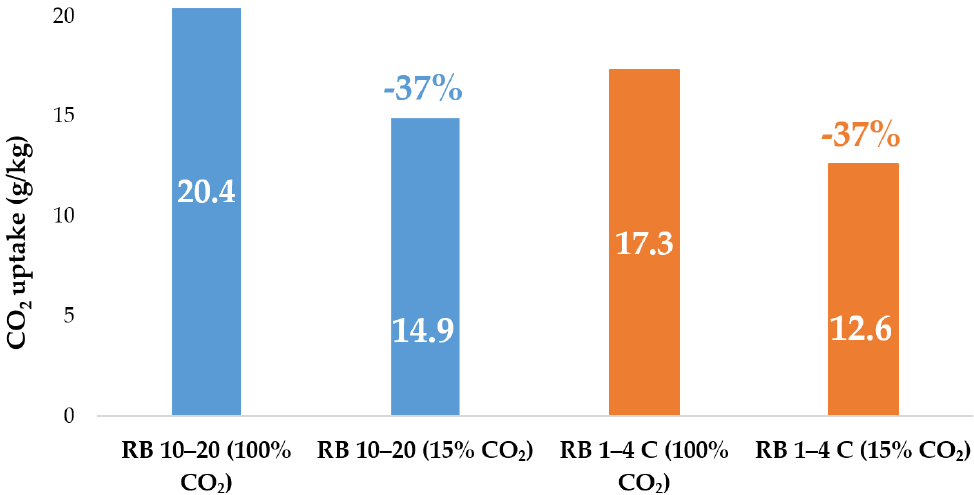
Figure 7. Effect of the CO 2 concentration on the CO 2 uptake (RB 10–20 and RB 1–4 C) (one accelerated carbonation test for these RCAs at these water